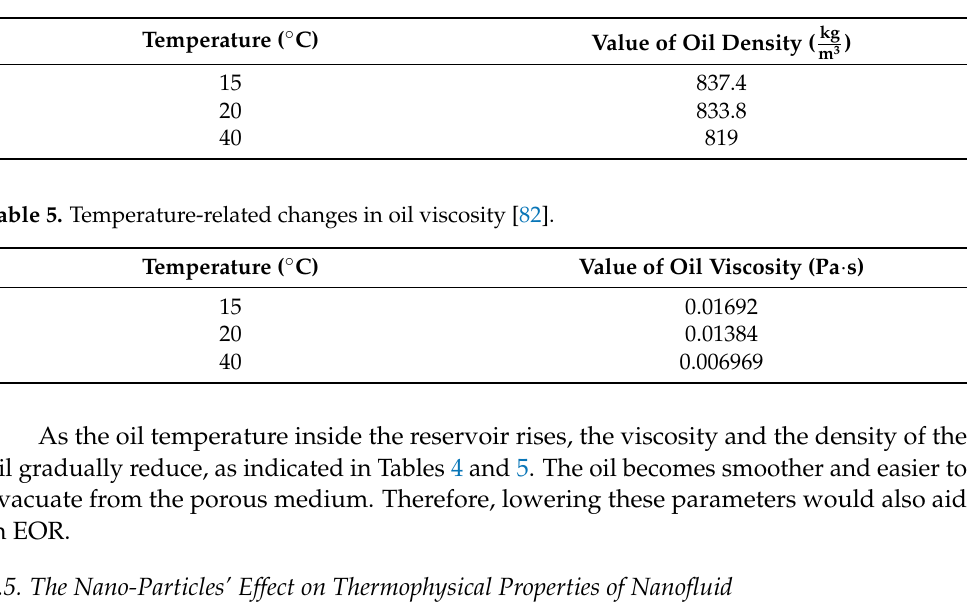
Table 4. Temperature-related changes in oil density [82].